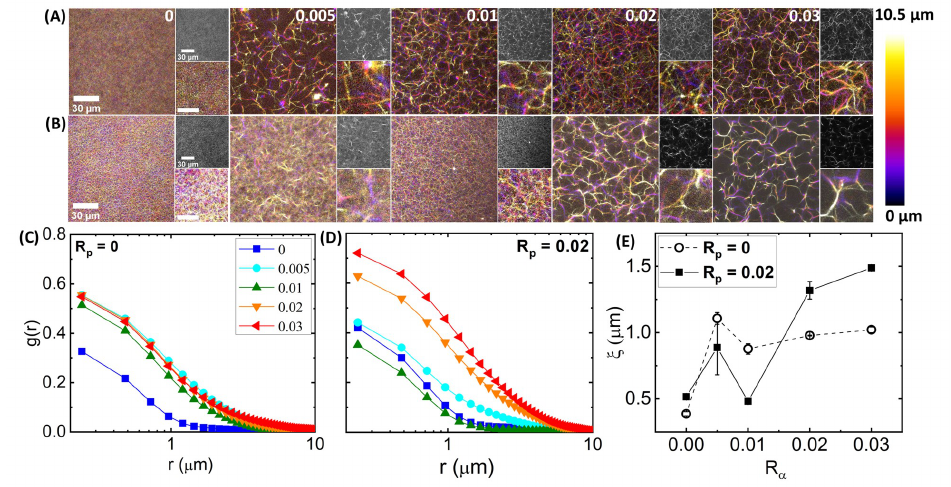
Figure 2. The structure and mobility of actin networks depend on the degree of filament crosslink- ing and stabilization . ( A , B ) Laser scanning confocal microscopy imaging of 5.8 µ m fluorescence- labeled actin networks with varying α -actinin:actin molar ratios R α = 0–0.03, increasing from left to right as indicated at the top right corner of each image. Networks ( A ) without phalloidin ( R p = 0) and ( B ) with a phalloidin:actin molar ratio R p = 0.02 depict the effect of filament stabilization on network structure. For each [ R α , R p ] combination, three-dimensional stacks of 21 images, each of 0.5 µ m thickness, were captured using a Leica TCS SP8 laser scanning confocal microscope with 60 × 1.4 NA objective. Large left-hand images are color-coded z -projections of the image stacks, with the color scale shown to the right and scale bars representing 30 µ m. Small images are single slices from the stack ( top ) and zoom-ins of the z -projections ( bottom ) with a scale bar indicating 10 µ m. ( C , D ) Spatial image autocorrelation functions, g ( r ) versus radial distance r , computed from each image of each z -stack shown in ( A , B ), quantify the average feature size of images. Each g ( r ) curve shown is the average over those obtained from each of the 21 images of the corresponding z -stack shown in ( A ) for each R α , as denoted in the legend, for networks with ( C ) R p = 0 and ( D ) R p = 0.02. ( E ) The correlation lengths ξ as a function of R α , obtained by fitting each average g ( r ) curve shown in ( C ) (open symbols, dashed connecting lines) and ( D ) (closed symbols, solid connecting lines) to an exponentially decaying function: g ( r ) = g ( 0 ) exp ( − r / ξ ) . Error bars are obtained by fitting g ( r ) for each image of the corresponding z -stack and computing the standard error across the 21 independent ξ values measured at different z -heights in the image